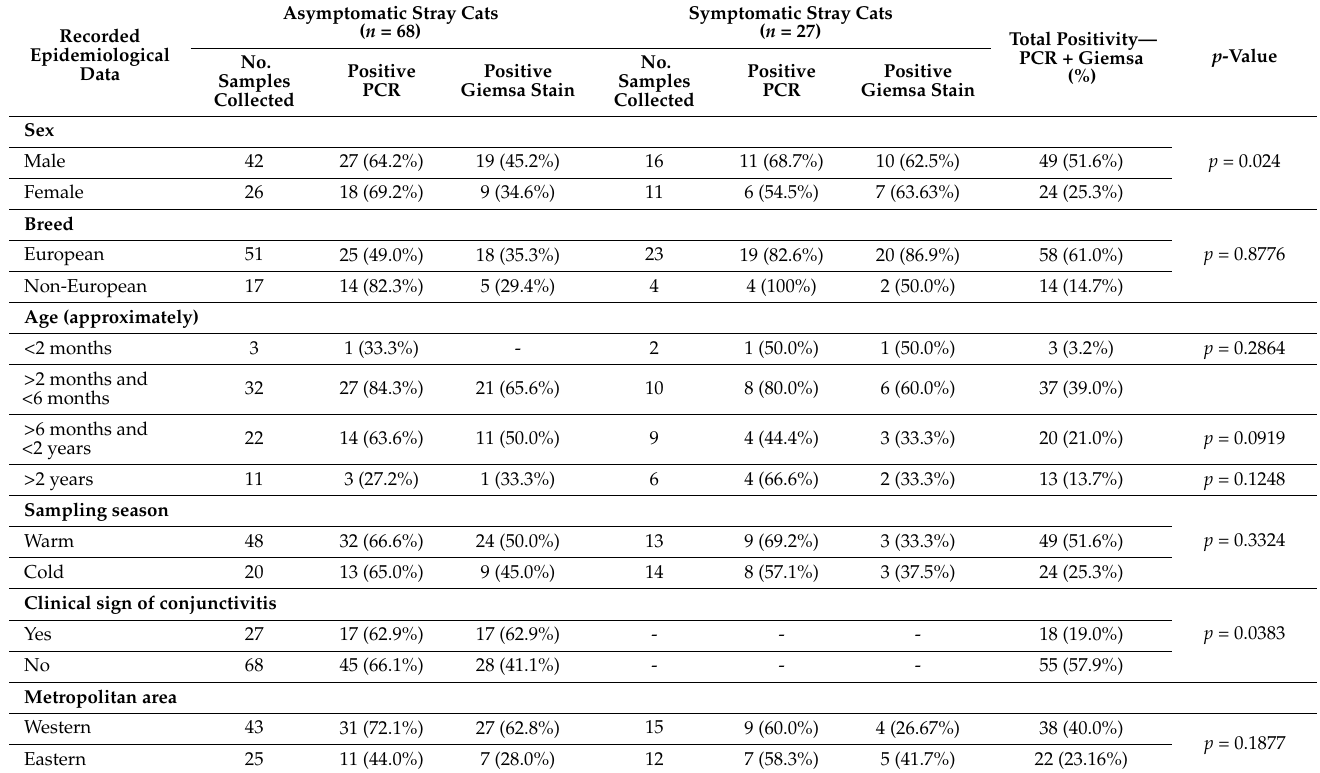
Table 1. Distribution of Chlamydia spp. infections in the monitored stray cats according to the recorded epidemiological